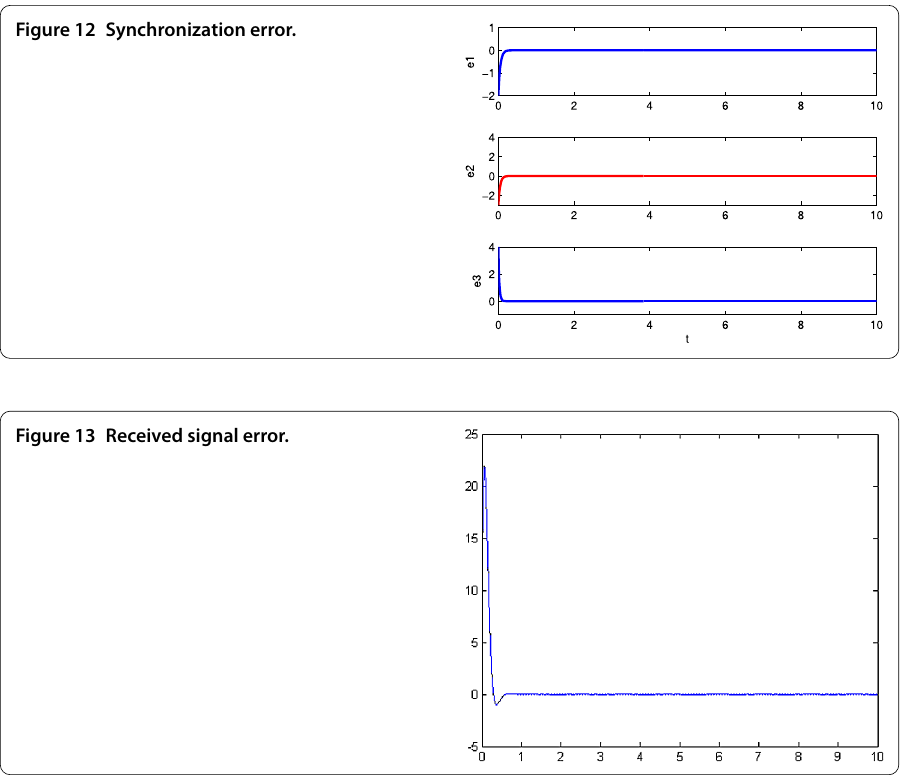
Figure 12 Synchronization error.